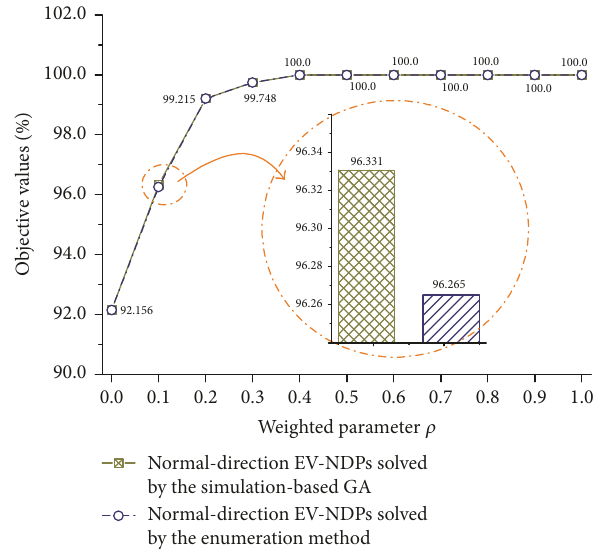
Figure 7: Comparison of the results of normal-direction EV-NDPs solved by the simulation-based GA and enumeration